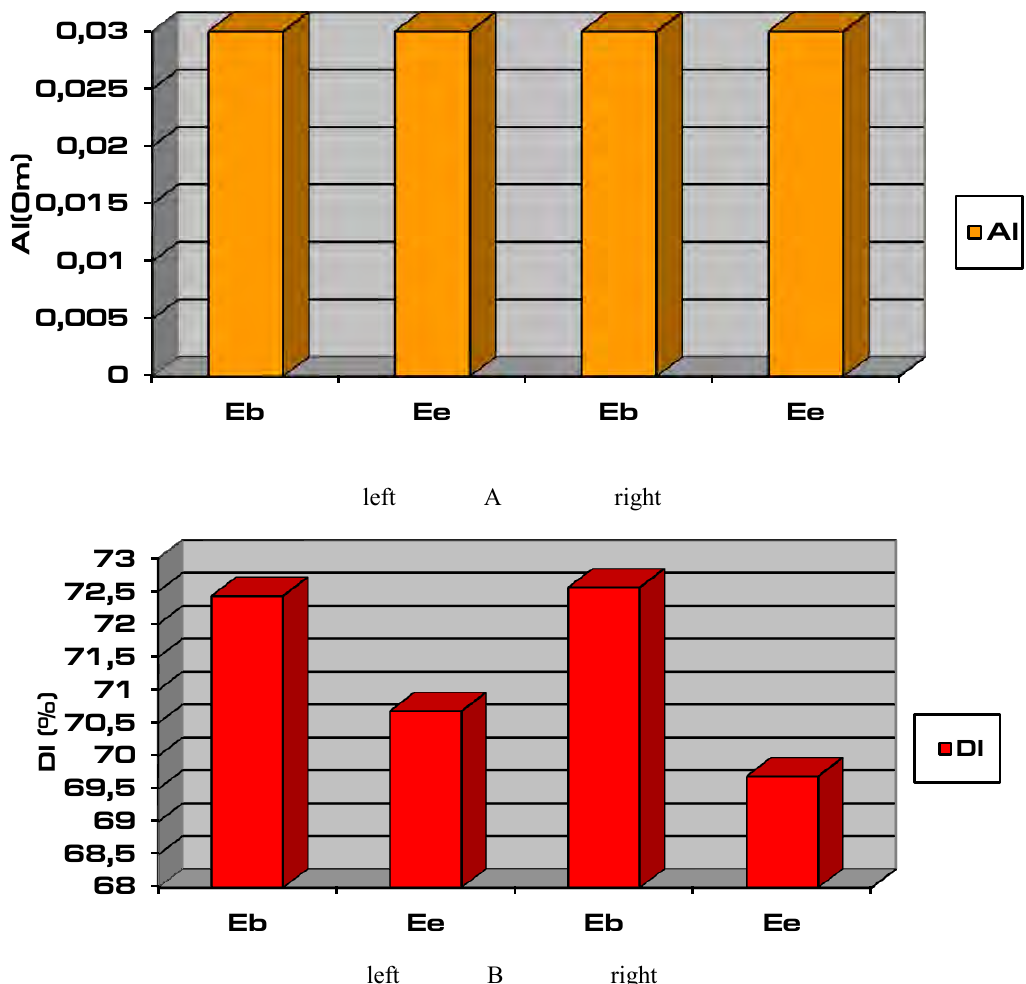
Figure 6. Indexes of peripheral vascular resistance in area of shallow arteries of cerebrum at sportsmen’s (Greek- Roman fight) before and after paravertebral miorelaxation (A - amplitude (absolute) indexes, B - amplitude (relative)): AI - amplitude of low wave; DI – dikrotic index; Eb - beginning of experiment; Ee - end of